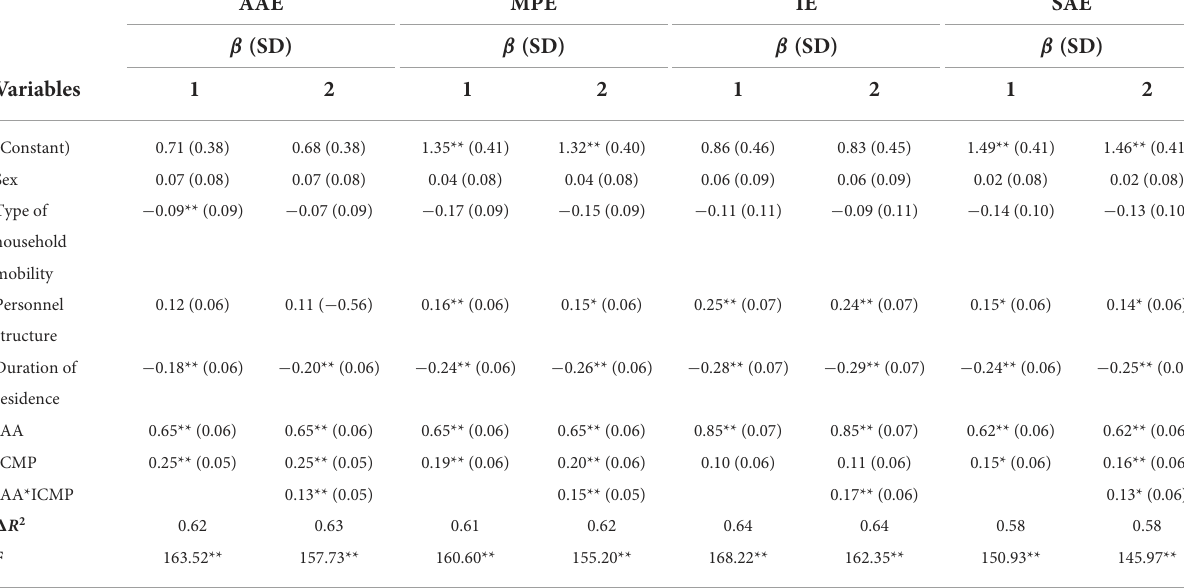
TABLE 5 Moderating effect of ICMP on the relationship between IAA and educational